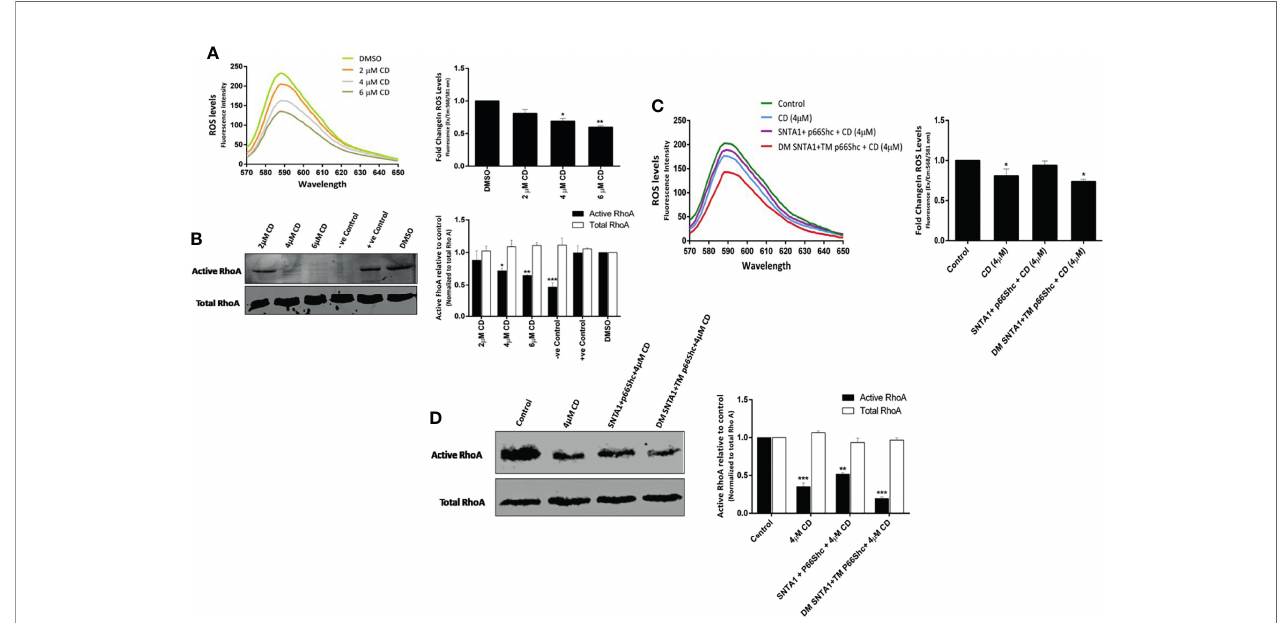
FIGURE 4 | Actin destabilization mediated loss of SNTA1-p66Shc interaction decreases RhoA activation in ROS dependent manner.The ROS andactivated RhoA (GTP- bound)levels were determinedin MDA-MB-231 cells treated with variousconcentrations of cytochalasin D (2µM, 4 µM, 6 µM) and/or with the indicatedplasmid constructs. (A) The emission spectraof amplex red reagent showingthe amount of H 2 O 2 generated inMDA-MB-231 cells treated with cytochalasin (D) ROS levels signi fi cantly declined incytochalasin D treated cells in comparison to control. The emission spectra were recorded in the wavelength range of570-650 nm recorded,under an excitation wavelength of 568 nm. The bar graphillustrates the fold change in l max ( fl uorescence intensity at 588 nm) inMDA-MB-231 cellsco-cultured with increased concentrations of cytochalasin (D) Results shown were repeated three times andare expressed as mean ± SD fold change over control level set to 1 unit. The statistical analysiswas done usingone-way ANOVA followed byDunnett`s multiple comparison test to determine level of signi fi cance. *P < 0.05; **P <0.01. (B) Representative western blot showing the relative levelsof active RhoA in cells treatedwith cytochalasin (D) The RhoA activation levelswere normalized against total RhoA fromwholecell lysates andthe relative change in active RhoA levels was determined incomparisonto control. Wholecell lysates pretreatedeither with GTP g S orGDP prior to precipitation with RhotekinRho binding domainwere used as positive control and negativecontrol respectively. DMSO was used as vehiclecontrol. RhoA activation assaysreveal that cytochalasin D treatment reduces the activation of endogenousRhoA. Densitometryanalysisof westernblots shows the relative change in RhoA protein activation levelsin response to cytochalasin D treatment. Results shown were repeated three times and are expressed as mean ± SD fold change over control level set to 1 unit. The statistical analysiswas done using two-way ANOVA followed bySidak`s multiplecomparisontest to determine levelof signi fi cance. *P < 0.05; **P <0.01; ***P < 0.001. (C) The emission spectra of amplex red reagent showingthe amount of H 2 O 2 generated inMDA-MB-231 cells transiently transfected with indicated plasmids followed bycytochalasin D treatment.